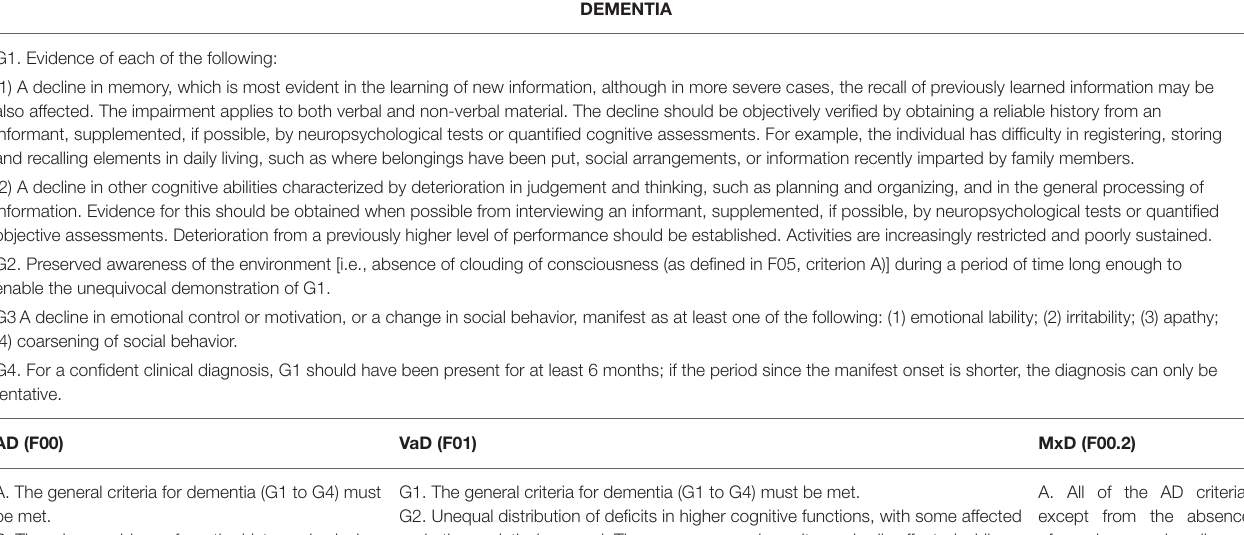
TABLE 1 | ICD-10 dementia research diagnostic criteria used in the study